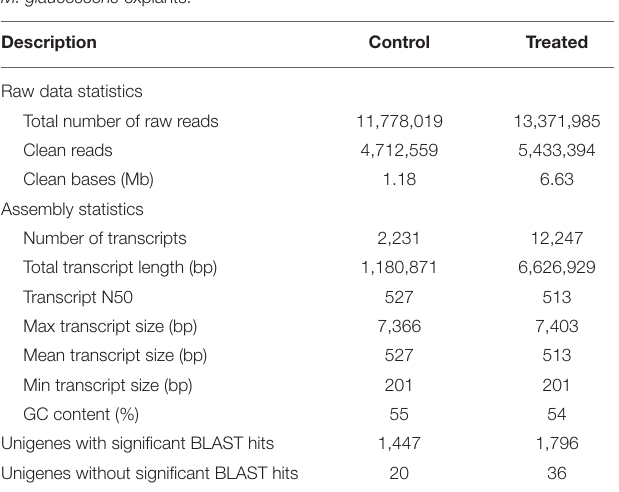
513 bp, a GC content of 54%, and maximum and minimum sizes of 7,403 and 201 bp, respectively ( Table 2